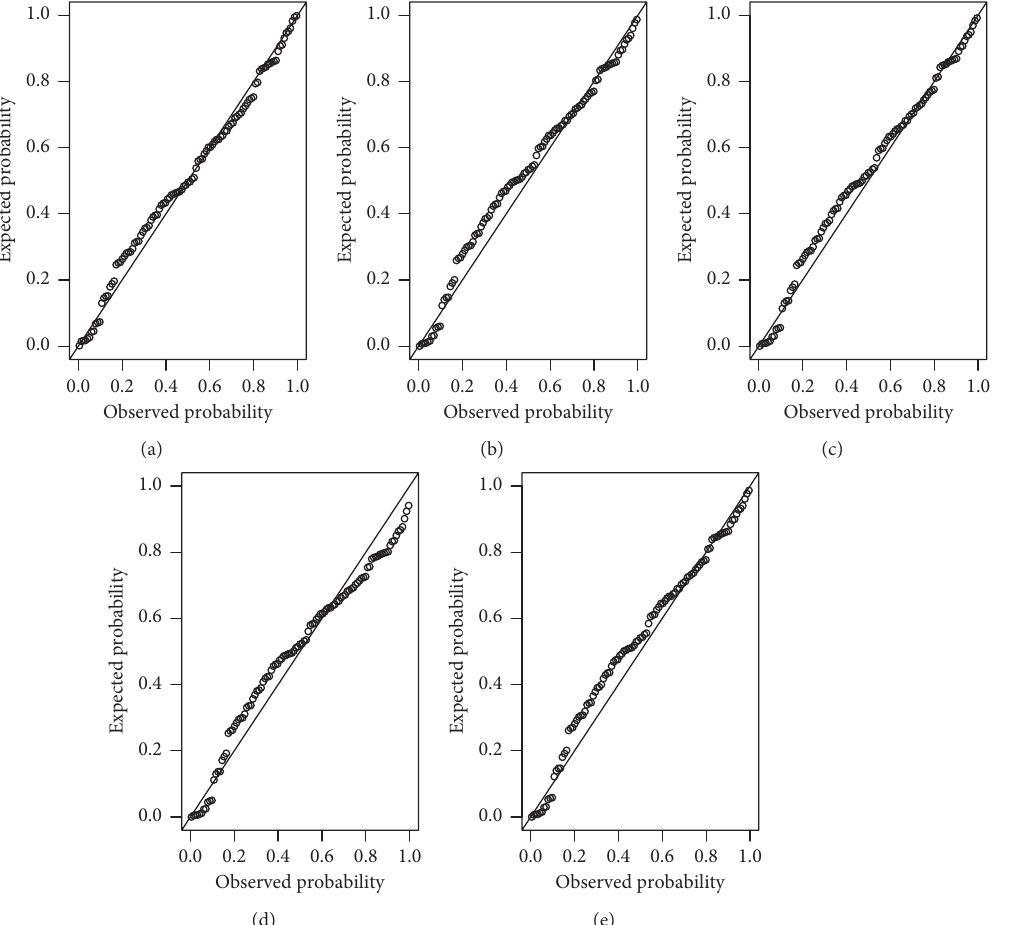
Figure 5: P-P plots of fitted distributions for data I: (a) BOIPE distribution. (b) B distribution. (c) K distribution. (d) BMOEE distribution. (e) ETL distribution.